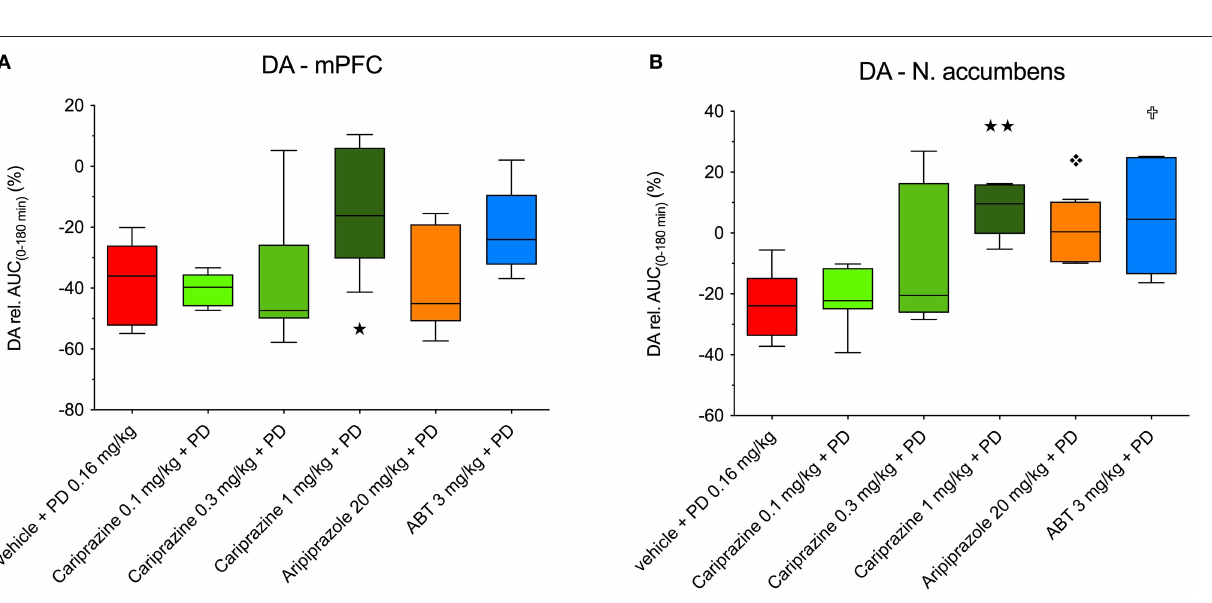
FIGURE 5 | The overall propensity of cariprazine, aripiprazole and ABT-925 to counteract the ( + )-PD 128907-induced decrease in basal extracellular levels of DA in the (A) mPFC and (B) nAcc shell of awake rats.